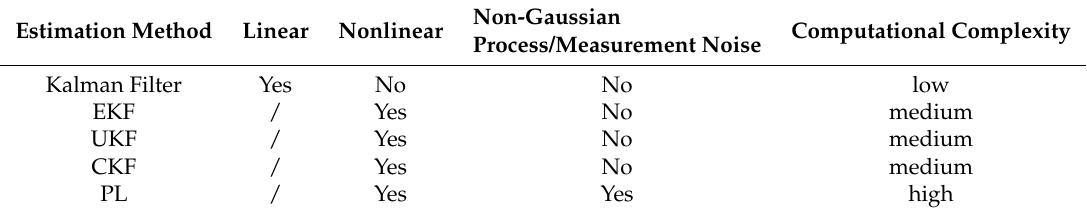
Table 2. The difference of state estimation method.